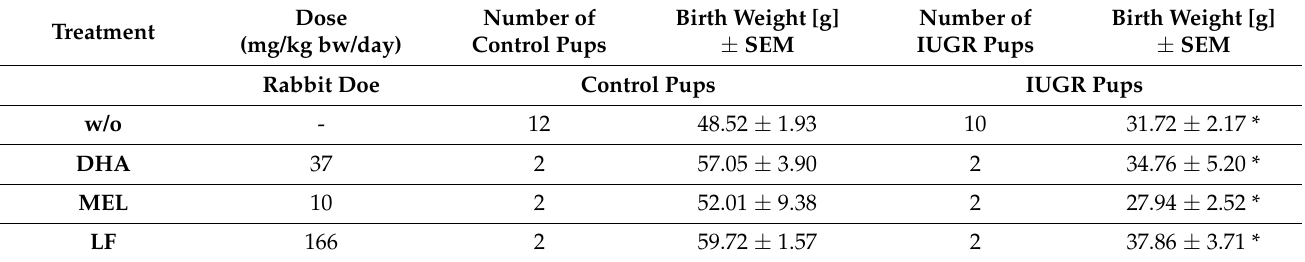
Table 1. Number and birth weight of PND0 rabbit pups included in the study.